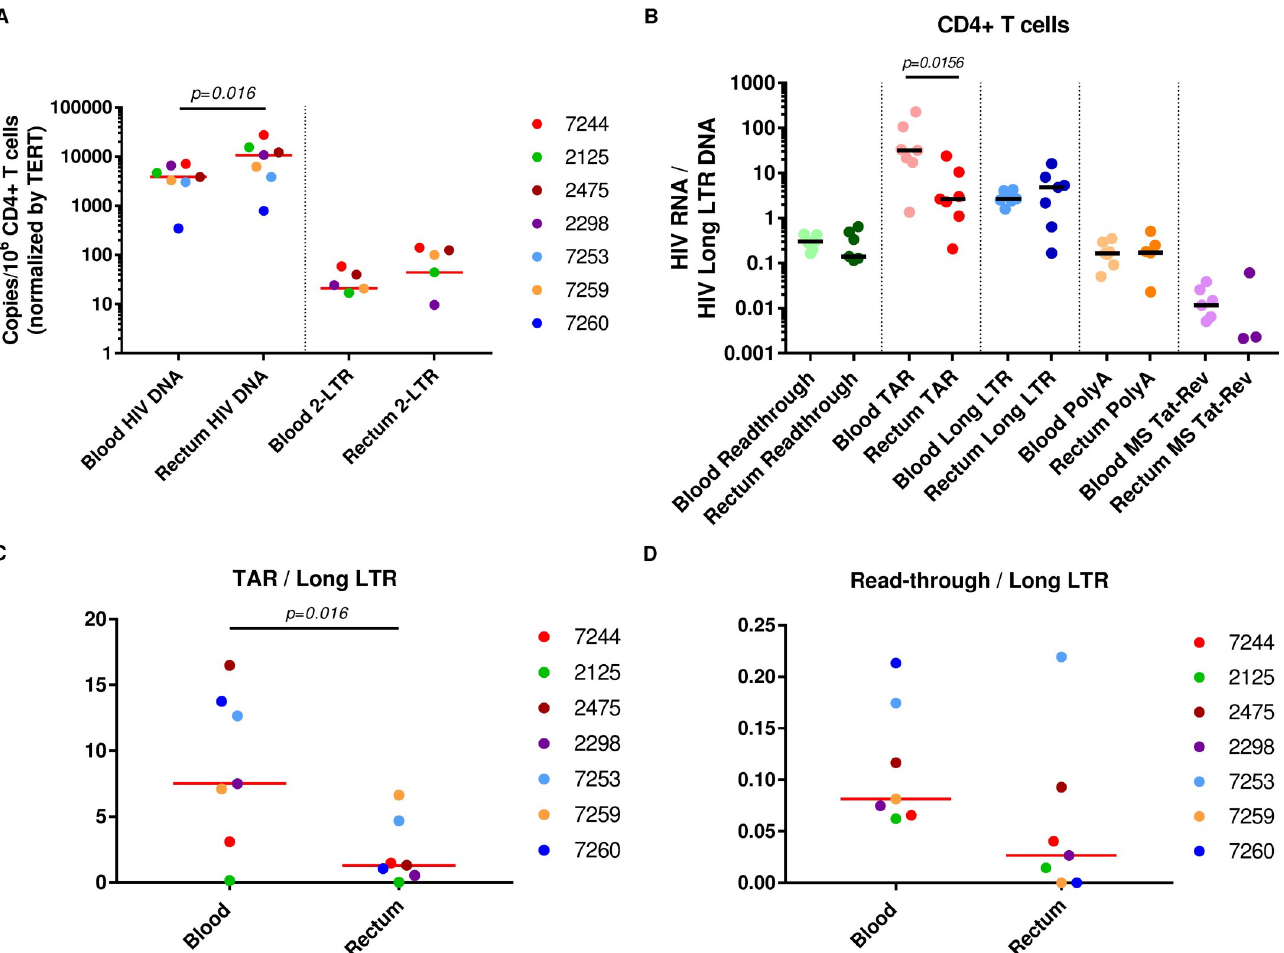
Fig 4. Levels of HIV DNA, 2-LTR circles, and blocks to transcription differ between CD4+ T cells from the gut and blood. (A) Levels of HIV DNA (Long LTR region) and 2-LTR circles were quantified in CD4+ T cells from the blood and rectum using ddPCR and expressed as copies per million CD4+ T cells (normalized by TERT). (B) The average levels per provirus of each transcript (ratio of each HIV RNA to the Long LTR HIV DNA) were measured in CD4+ T cells isolated from the blood and rectum (n = 7 matched individuals) . (C) The ratio of TAR to Long LTR RNA was determined to compare the block to transcriptional elongation in CD4+ T cells from the blood and rectum. (D) The ratio of Read-through to Long LTR RNA was determined to assess the contribution of transcriptional interference to the block to HIV transcription initiation in rectal CD4+ T cells relative to peripheral CD4+ T cells. Bars represent medians. Comparisons between transcripts were performed using the Wilcoxon signed-rank